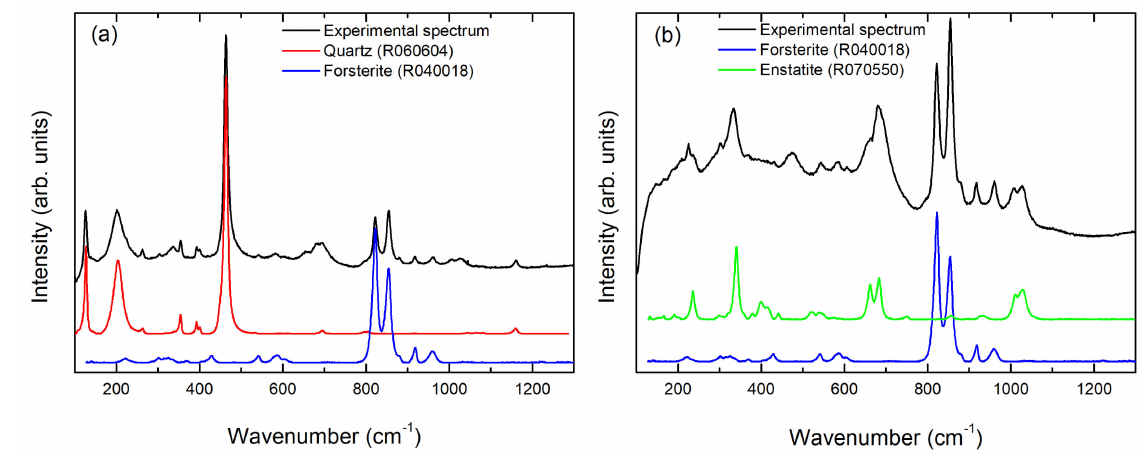
Figure 5. Typical Raman spectra of the thermally treated garnierite powder (black lines), ( a ) quartz and forsterite, and ( b ) forsterite and enstatite. The reference spectra used for the identification of the phases. Colors are described in the legend; reference spectra are from the RRUFF